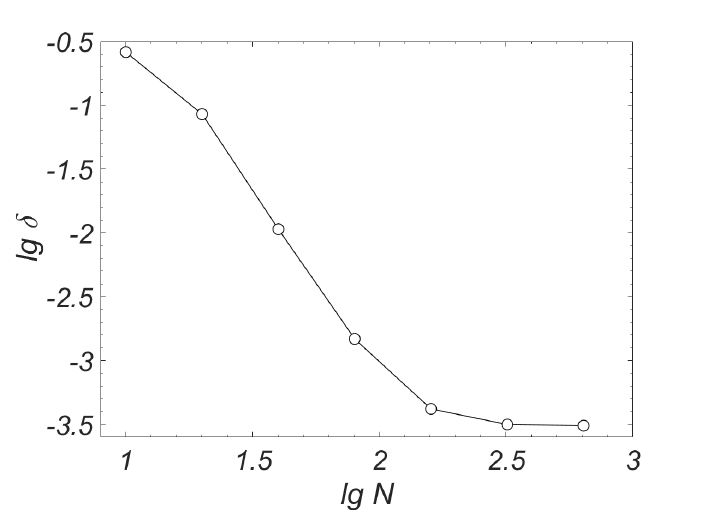
Figure 7. Fabry–Perot interferometer. The error of calculating the spectrum in the Hausdorff metric (40), depending on the number of steps along the ray coordinate. Notations correspond to Figure 5.